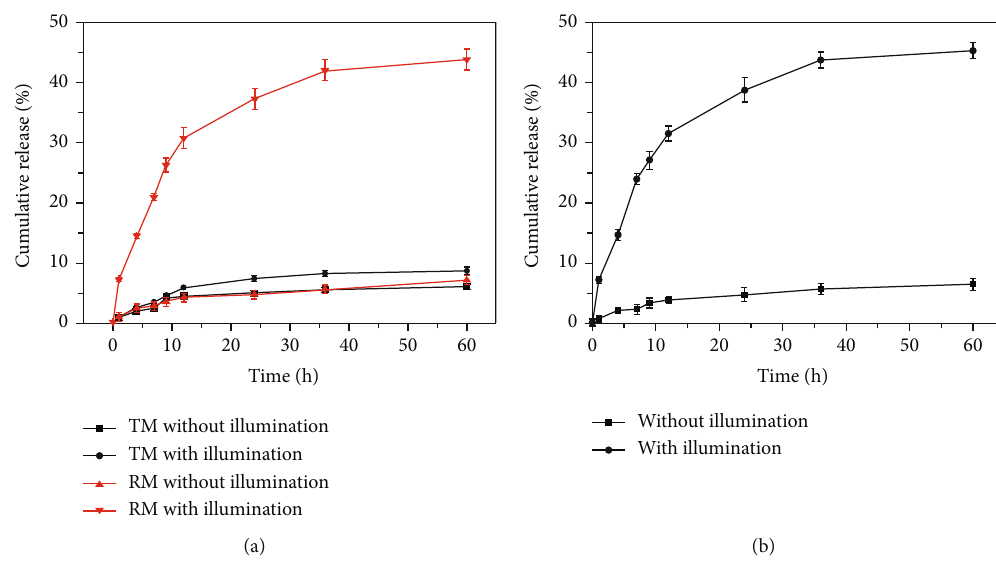
Figure 4: The release pro fi les of Ce6 from the controls of TM and RM (a) and TRM